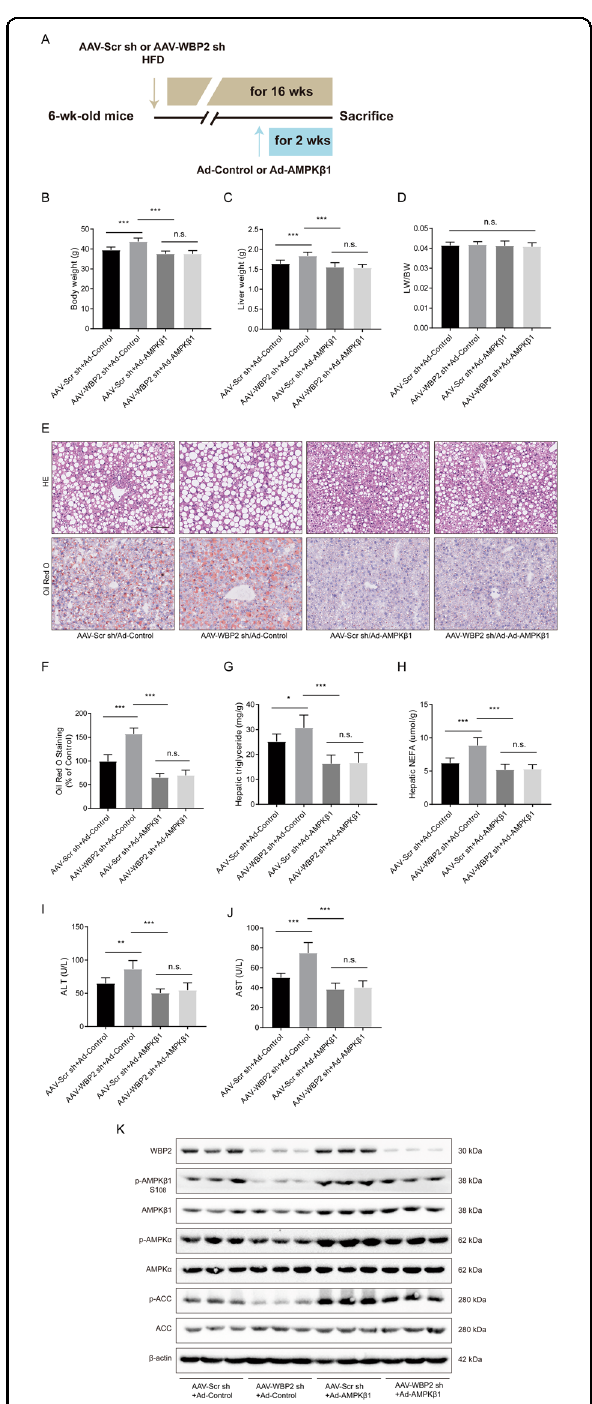
Fig. 7 AMPK β 1 reversed the phenotype induced by WBP2 knockdown. A Schedule of manipulating the expression of AMPK β 1. Six-week-old mice were injected with AAV-Scr sh (as a control) or AAV- WBP2 sh (knockdown WBP2) via the tail vein and fed an HFD. Ad- Control or Ad-AMPK β 1 was injected at the 14th week after HFD feeding, and the mice above were sacri fi ced 2 weeks later. B Body weight, C liver weight, and D LW/BW of the mice from the indicated groups ( n = 8/group). E , F Representative images of H&E and Oil red O staining of liver tissues from the mice from the indicated groups. Scale bar, 100 μ m. G , H Triglyceride, NEFA, and I , J ALT and AST levels in the livers of the mice from the indicated groups fed an HFD for 16 weeks ( n = 8/group). K Western blot assays were performed to detect the expression of WBP2, p-AMPK β 1, AMPK β 1, p-AMPK α , AMPK α , p-ACC, and ACC in the livers of the mice from the indicated groups. β -actin served as the loading control. Data represent the mean ± SEM, * P < 0.05, ** P < 0.01, *** P < 0.001 and n.s. indicates no signi fi cance between the two indicated